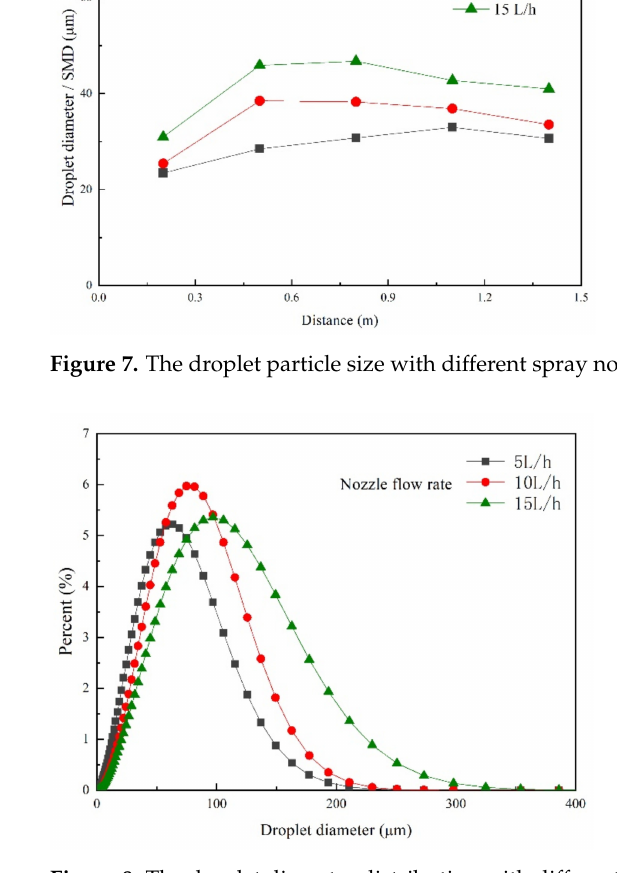
Figure 8. The droplet diameter distribution with different spray nozzle flow rate.